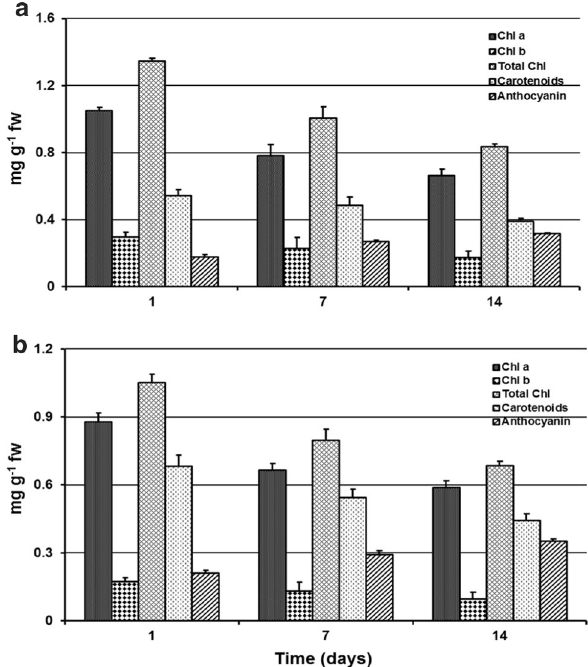
Fig. 4 Concentrations of photosynthetic pigments and anthocyanins in T. latifolia of the microcosms ( a ) Fe and ( b) Fe–Cu. Error bars rep- resent SD ( n = 3)